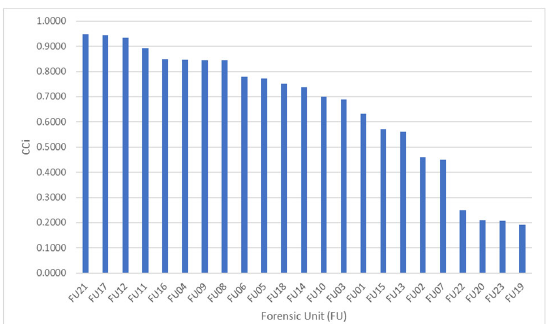
Fig. 2 . Final ranking produced by R-TOPSIS (CCis in descending